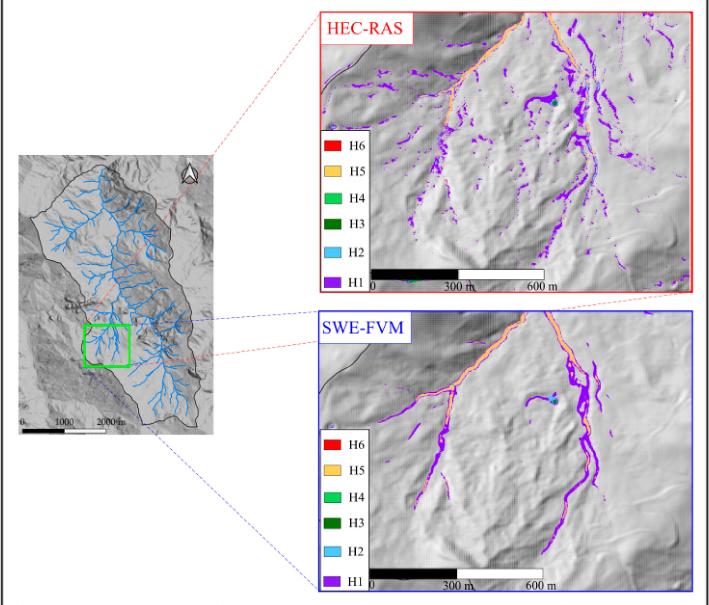
Figure 11. Hazard maps computed by HEC-RAS and SWE-FVM for water depth threshold equal to 0.05 m, considering T = 200 years and grid size 5